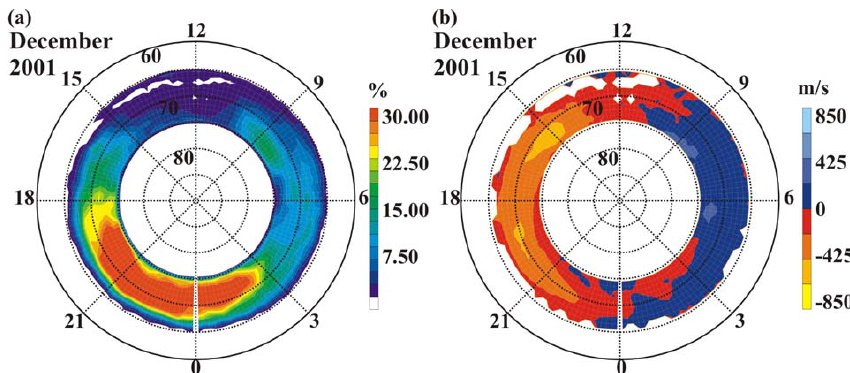
Figure 3. Stokkseyri echo occurrence rate and averaged line-of-sight velocity for winter (December 2001) in magnetic latitude – magnetic local time coordinates. Only data in beams 0–5 were considered.